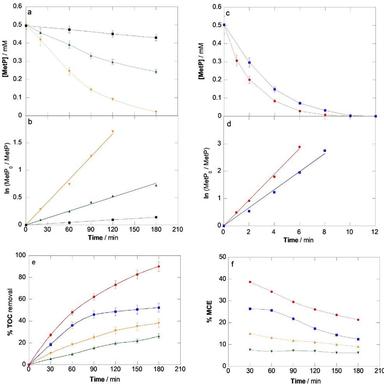
Effect of different H2O2 based EAOPs ( )AO-H2O2, ( )AO-H2O2/UV, ( ) EF and ( ) PEF on the treatment of 0.50 mM of MetP solutions at pH 2.5 and j ¼ 33.3 mA cm2 . (a) and (b) MetP degradation over time; (c) and (d) Pseudo-first order kinetics; (e) TOC removal over time; (f) mineralization efficiency over time. (-) only UVC light.